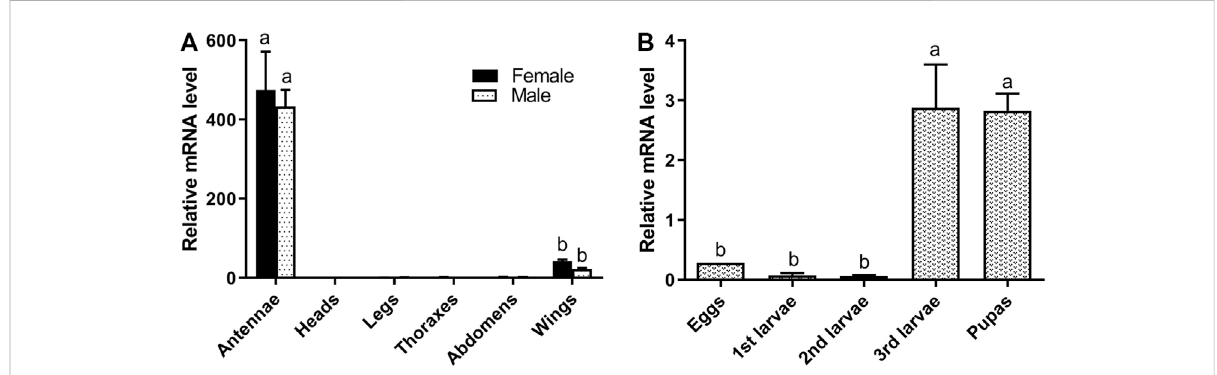
FIGURE 1 Relative expression levels of DtarORco in adult antenna, head, leg, thorax, abdomen, wing (A) and in different life stages or among different instars (B) using RTqPCR. The relative expression level is indicated as mean ± SE (N = 3). Different capital letters mean signi fi cant difference between tissues ( p <